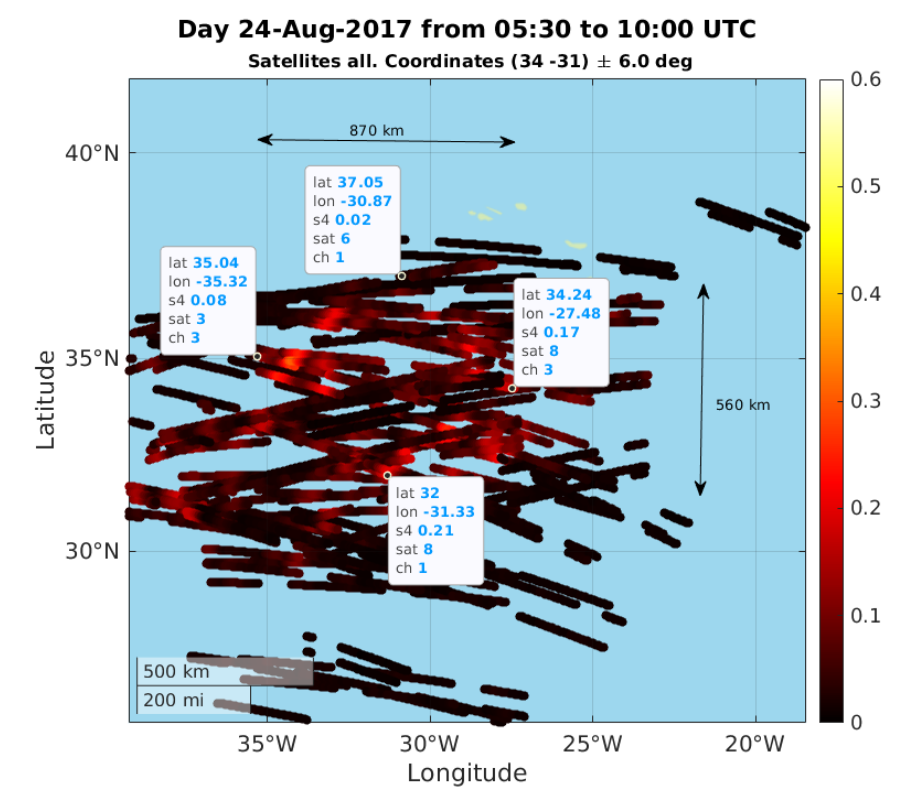
Figure 13. Peak in S 4 value in eastern part of northern Atlantic on 24 August